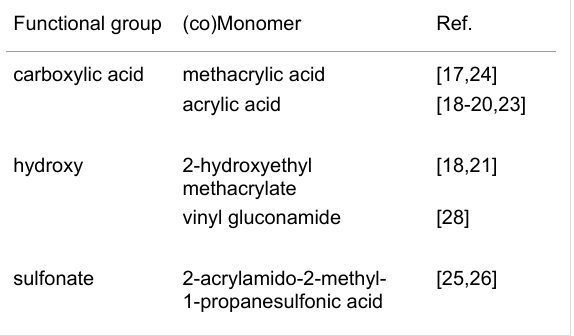
Table 2: Functional monomers or comonomers polymerized in inverse miniemulsion (crosslinkers are not mentioned here). Functional group